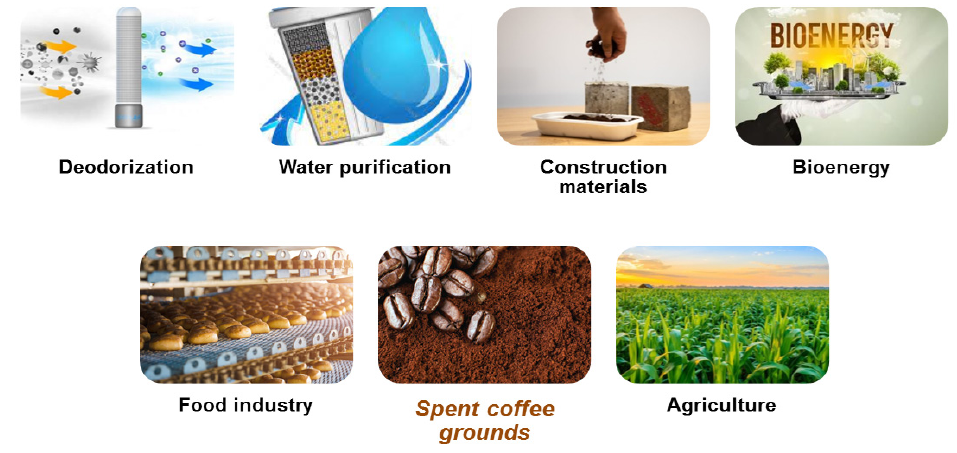
Figure 3. Applications of spent coffee grounds including agriculture, food industry deodorization, water treatment, construction materials, and bioenergy.